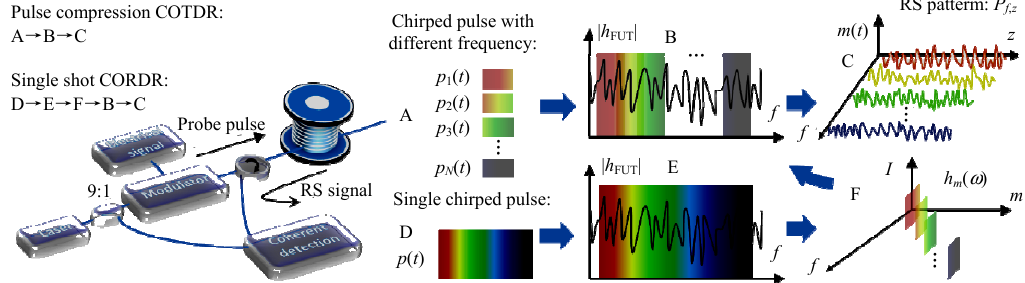
Fig. 17 Principle of sub-chirped-pulse extraction algorithm based on coherent detection [54].